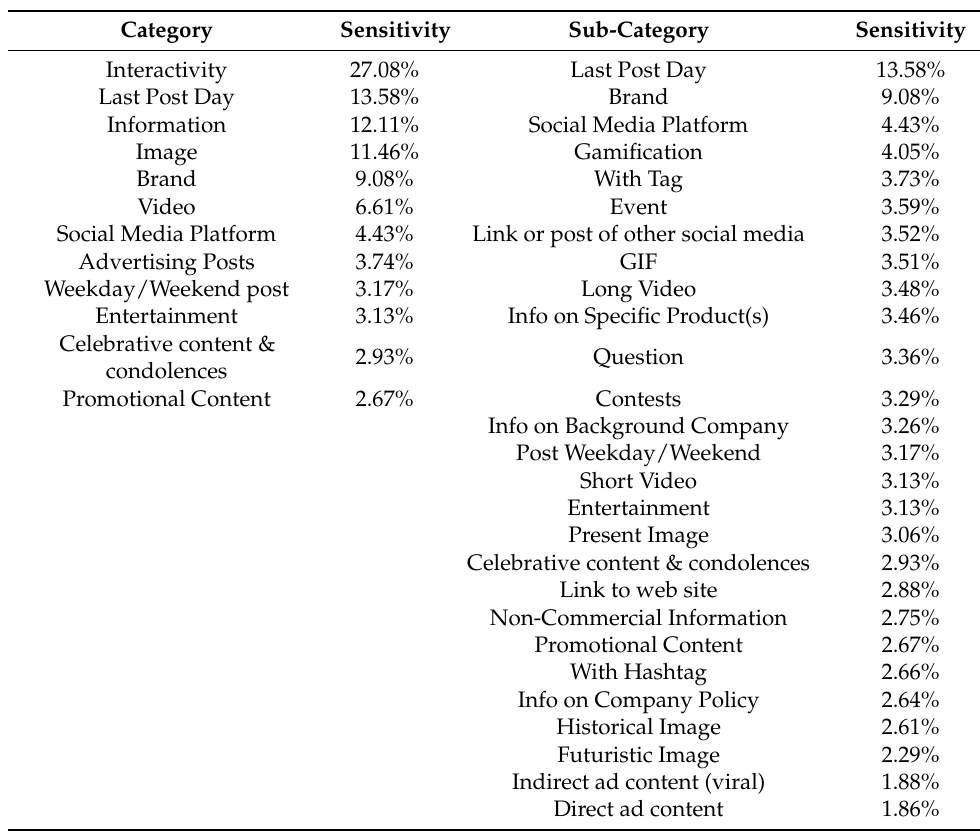
Table 4. Artificial Neural Networks (ANN) sensitivity